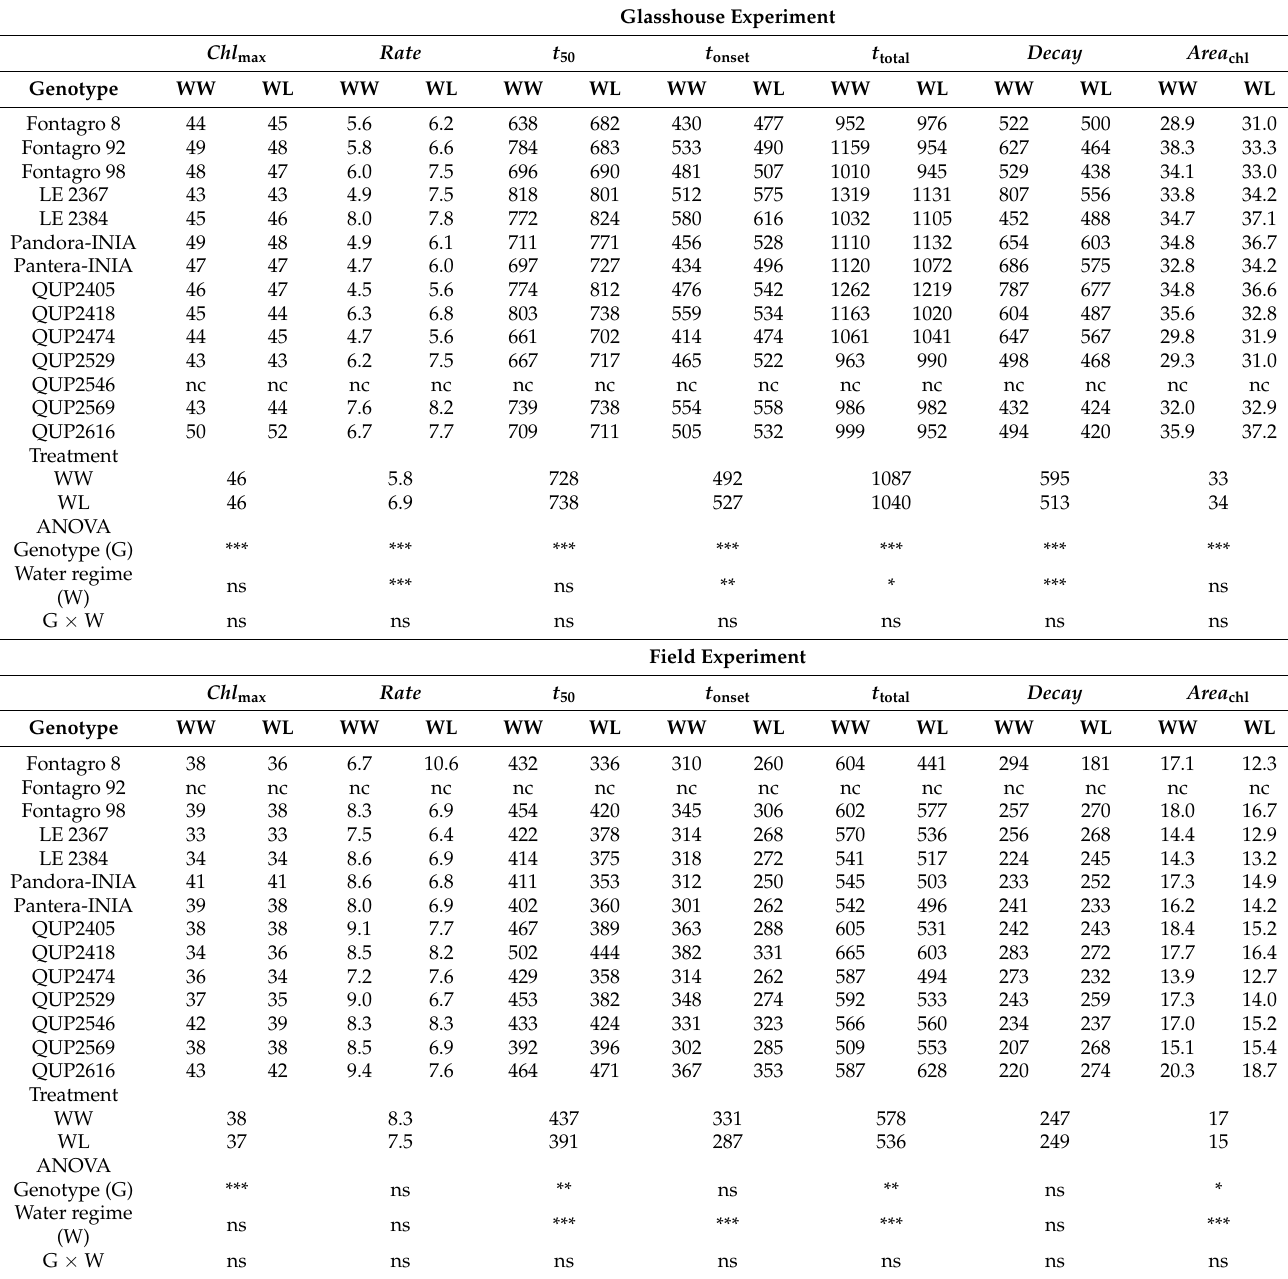
Table 1. Mean values of Chl max (dualex units), rate (dualex units ◦ Cd − 1 ), t 50 ( ◦ Cd), t onset ( ◦ Cd), t total ( ◦ Cd), decay ( ◦ Cd) and Area chl (Mdualex units ◦ Cd − 1 ) for a set of contrasting spring bread wheat genotypes grown under water-limited (WL) and well-watered (WW) regimes in glasshouse and field conditions. Significance levels for the analysis of variance (ANOVA) are also